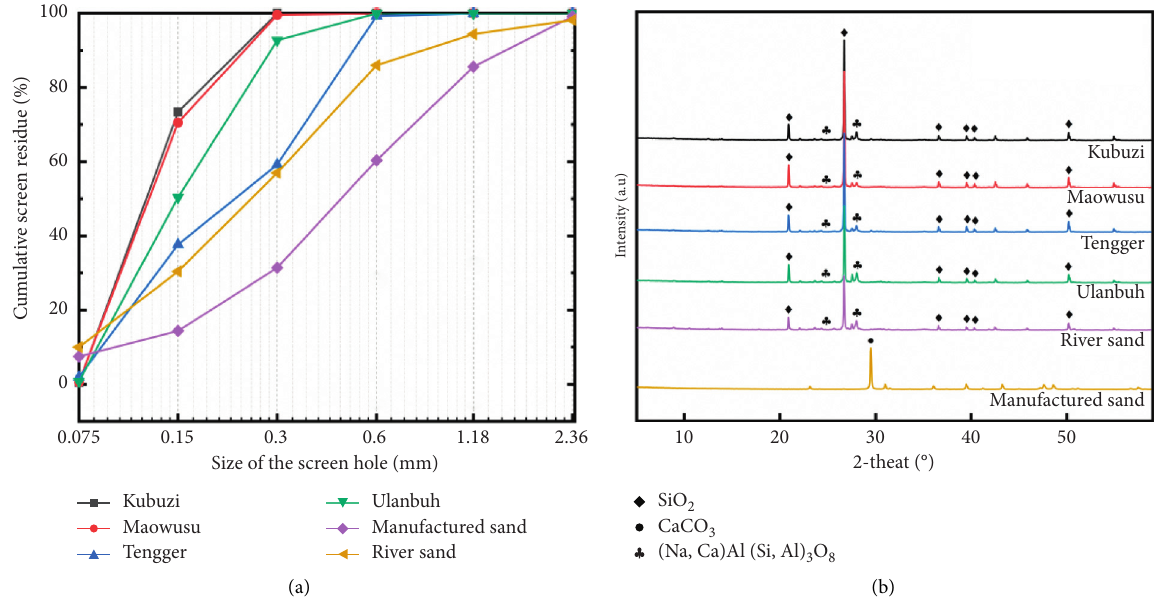
Figure 2: Comparison of characteristics among four kinds of desert sand and traditional sand used in this experiment. (a) Grading curve and (b)